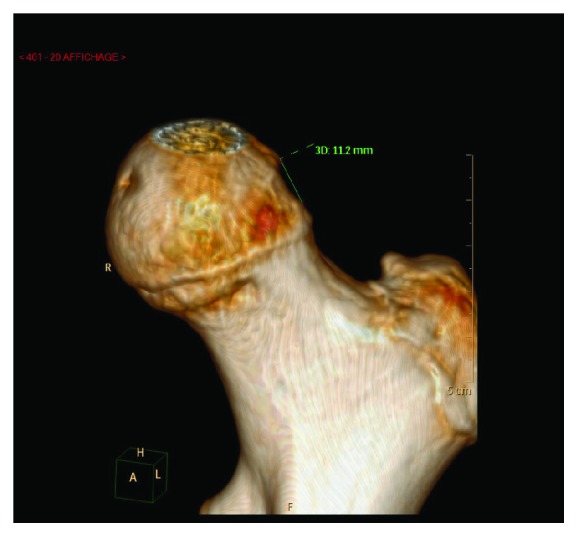
Hip CT-scan 3D view.